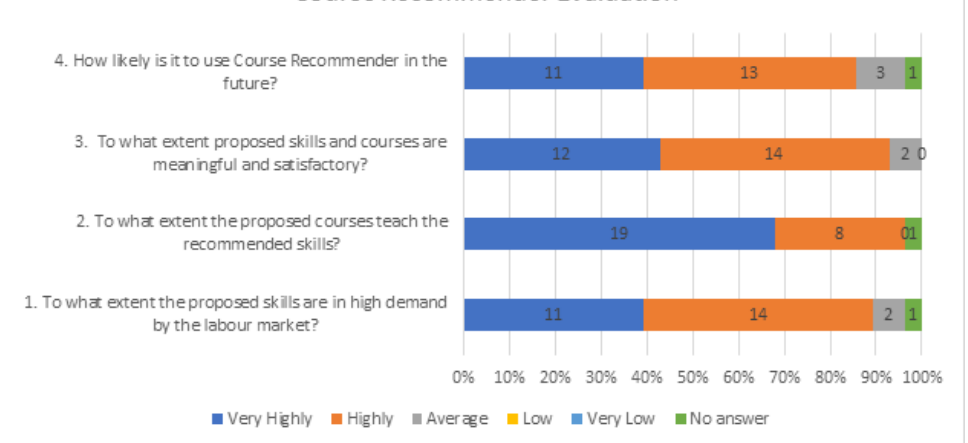
Figure 15. Course Recommender evaluation by university students.